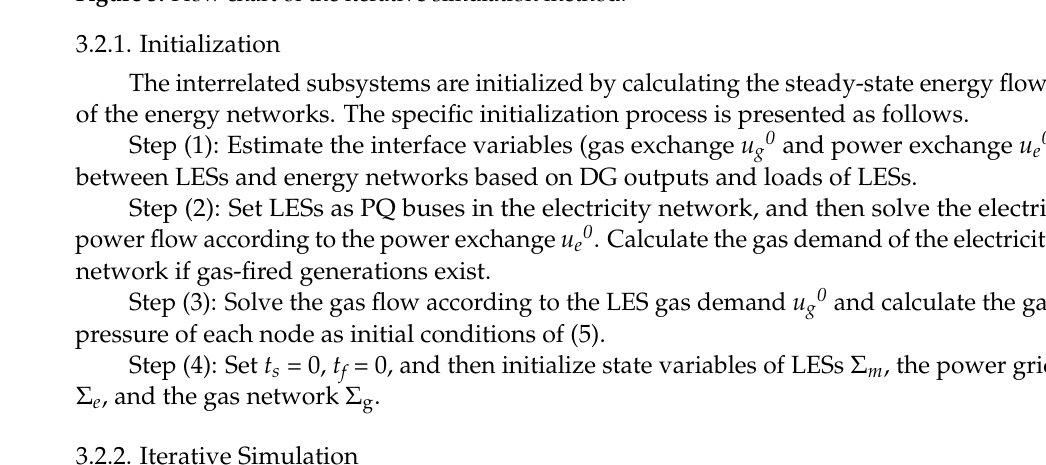
Figure 3. Flow chart of the iterative simulation method.